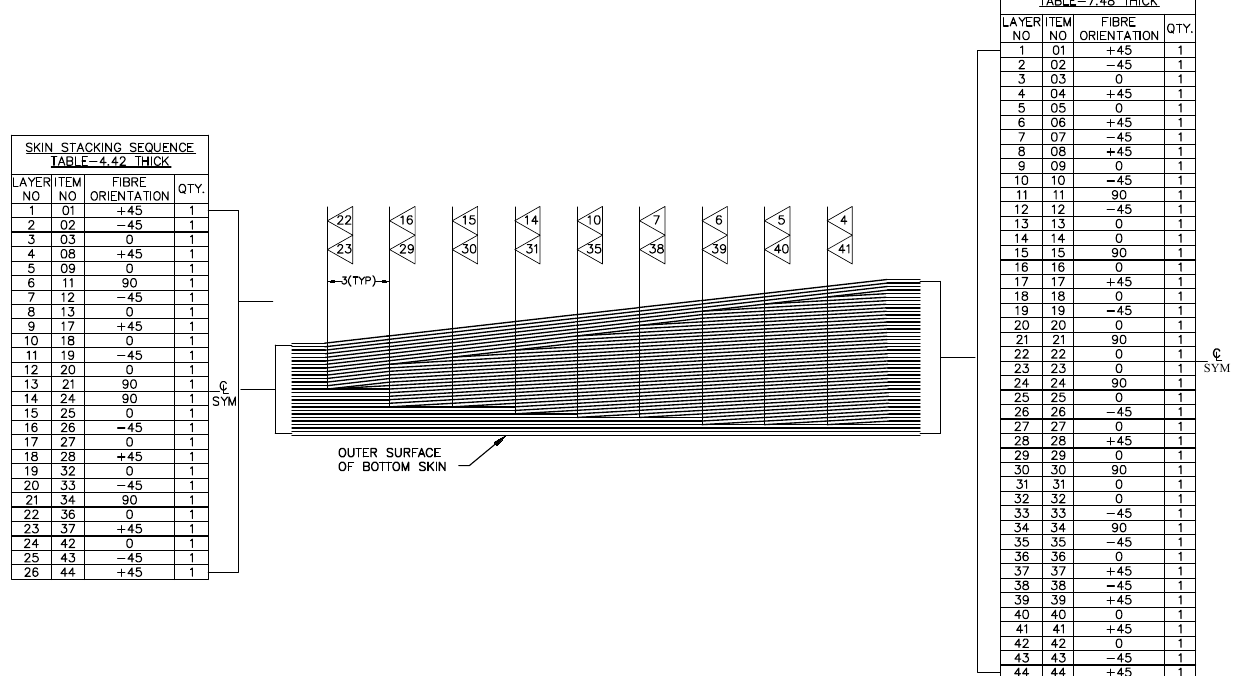
Figure 5. Layup sequence and thickness variation in the skin near the